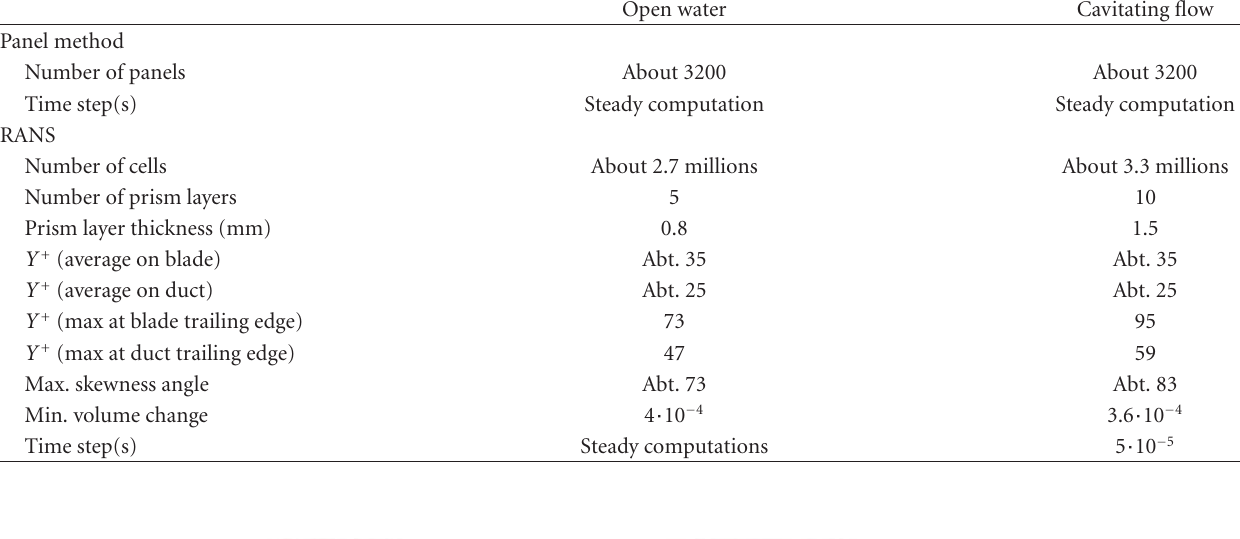
Table 1: Main discretization parameters.